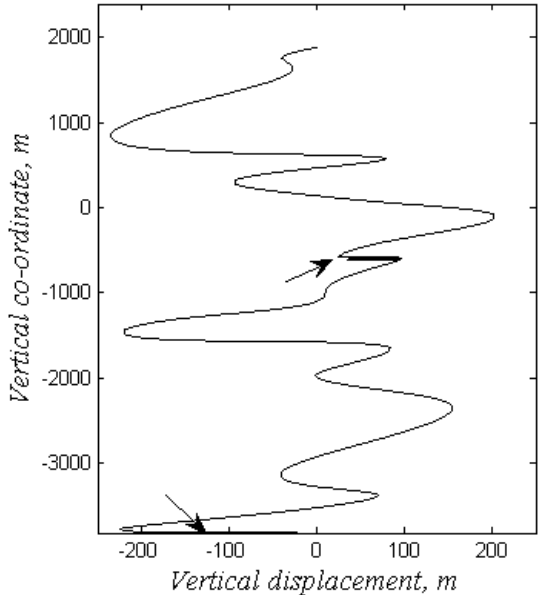
Fig. 5. The multivalues (indicated by arrows) arising in the vertical profile E(z)(x 0 = 0 ) for M 0 = 0 . 52, ν V =